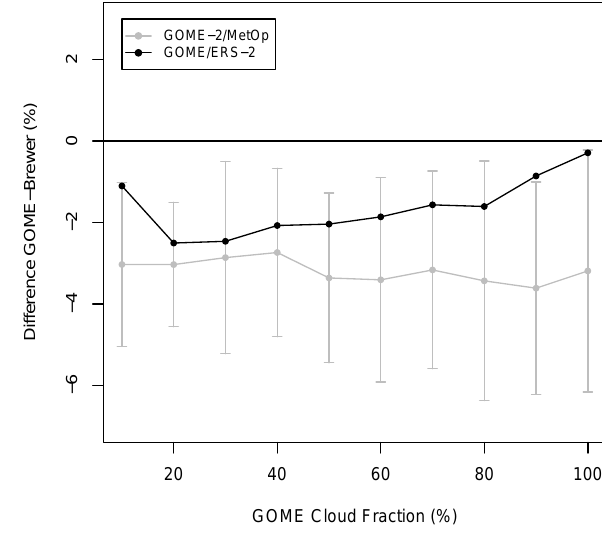
Fig. 4. Dependence of GOME-Brewer relative differences with re- spect to the GOME cloud cover fraction (CF) for the “Iberian Penin- sula”